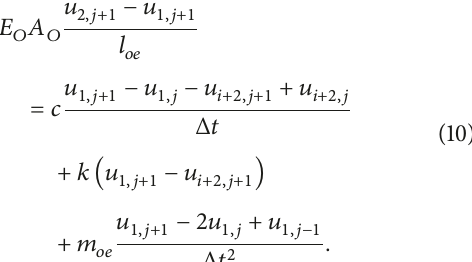
Figure 5: Force analysis of a shock absorber.